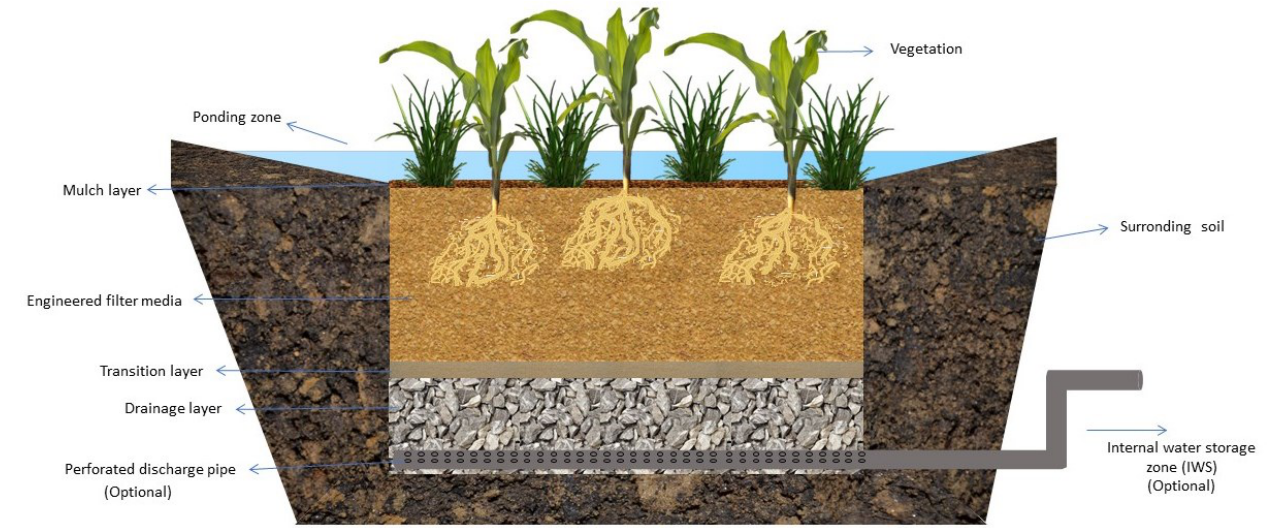
Figure 1. Schematic representation of a bioretention